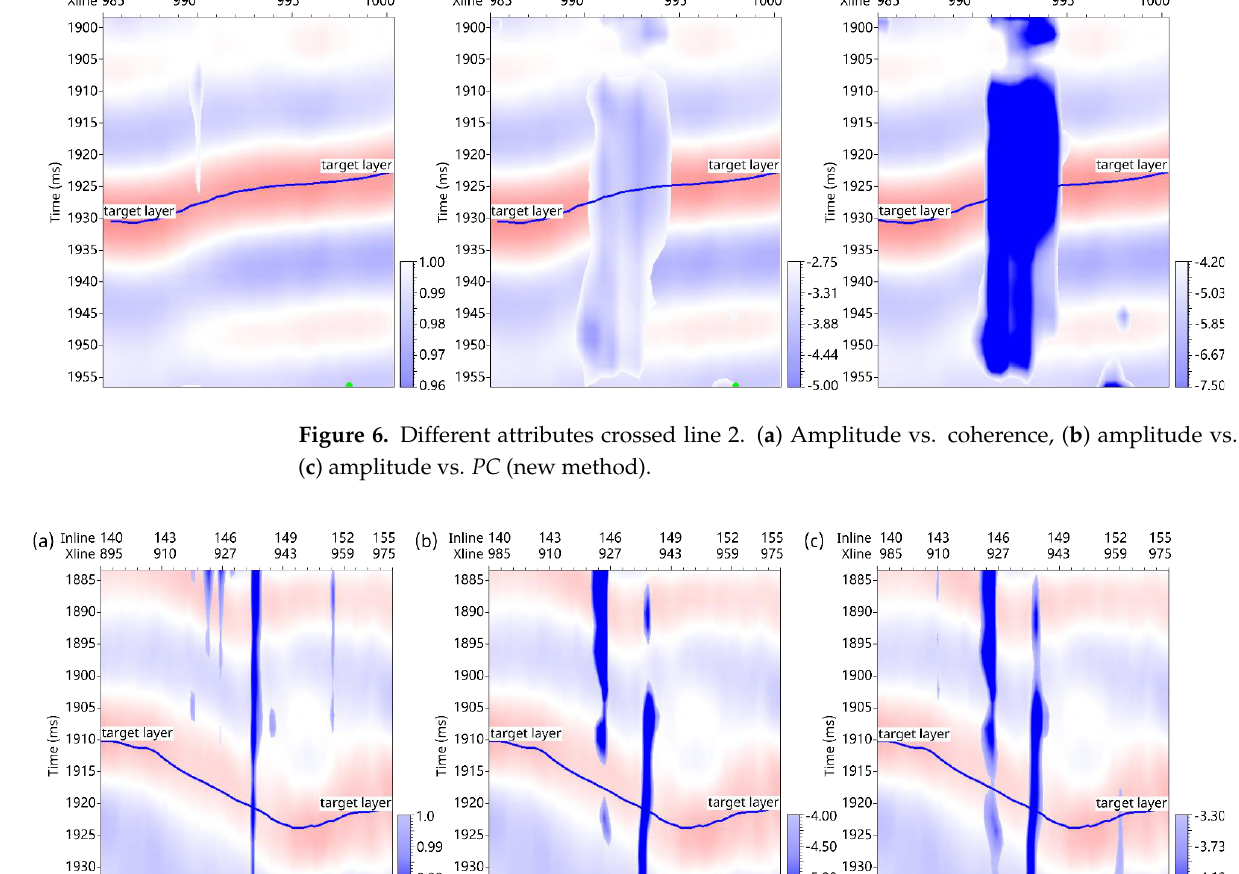
Figure 5. Different attributes crossed line 1. ( a ) Amplitude vs. coherence, ( b ) amplitude vs. PC , ( c ) amplitude vs. PC (new method).